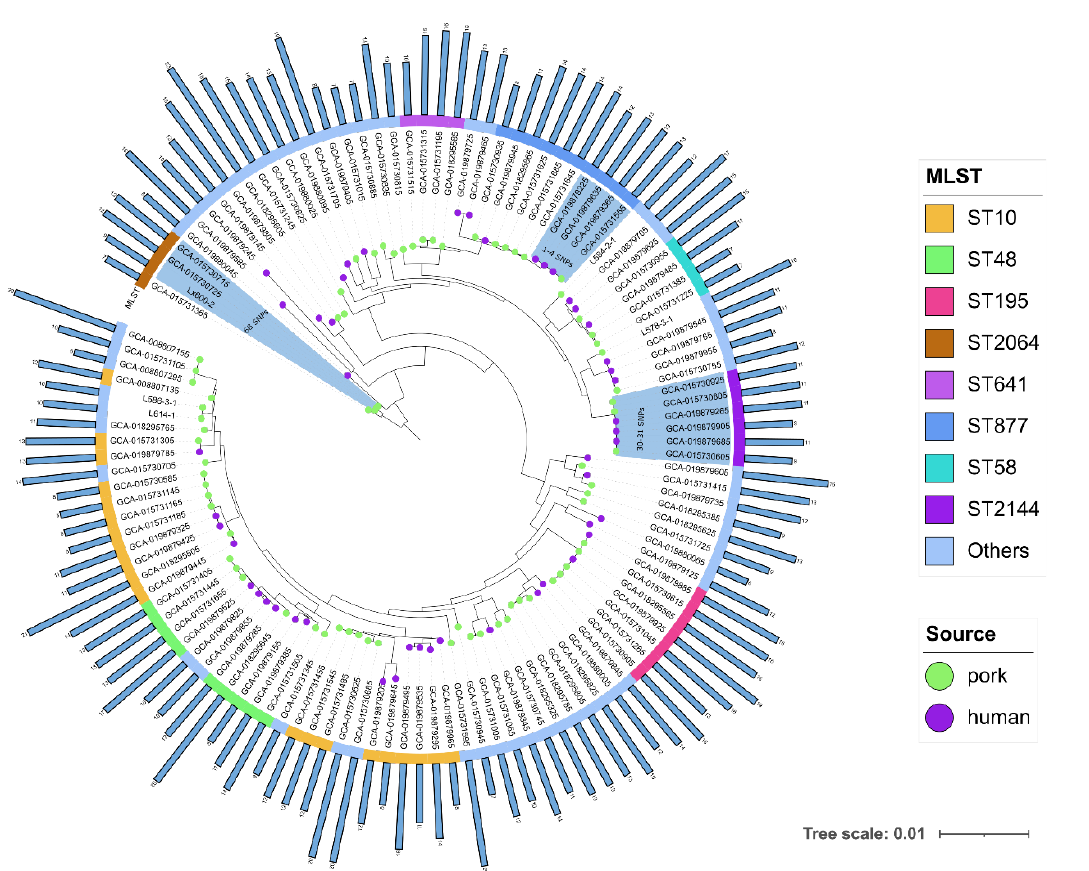
Figure 1. Phylogenetic analysis of 122 tet (X4)-positive E. coli isolates from pork and human samples. Blue-shaded areas represent strains with minor SNP differences. Histograms represent the number of resistance genes carried in the isolates.